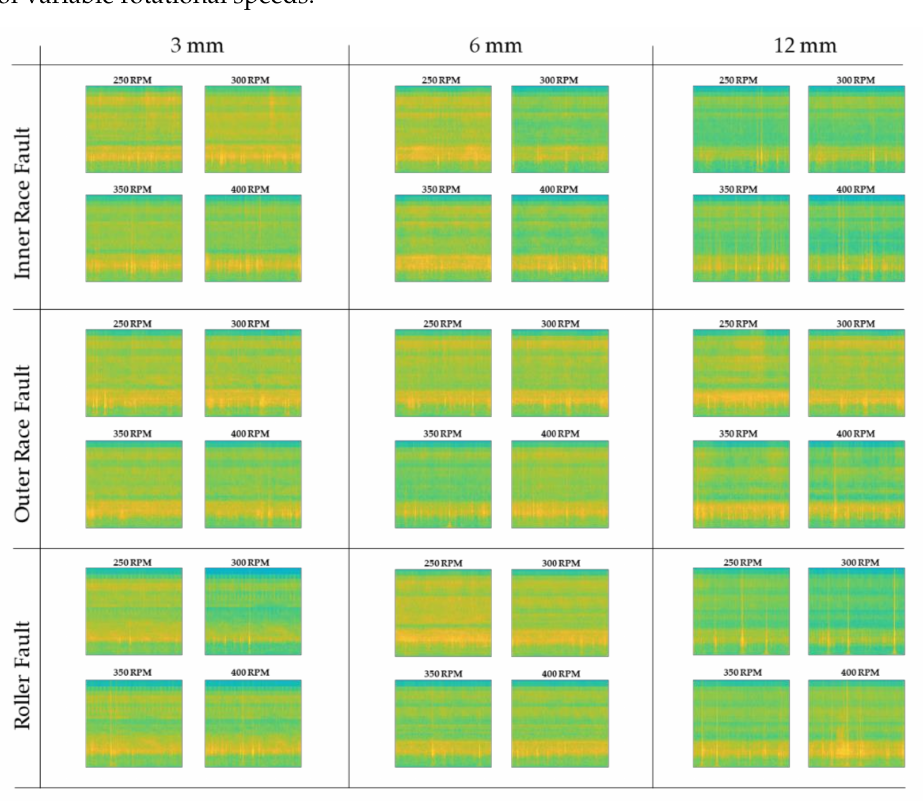
Figure 2. 2D spectrograms of single fault types with various levels of degradation at different rotational